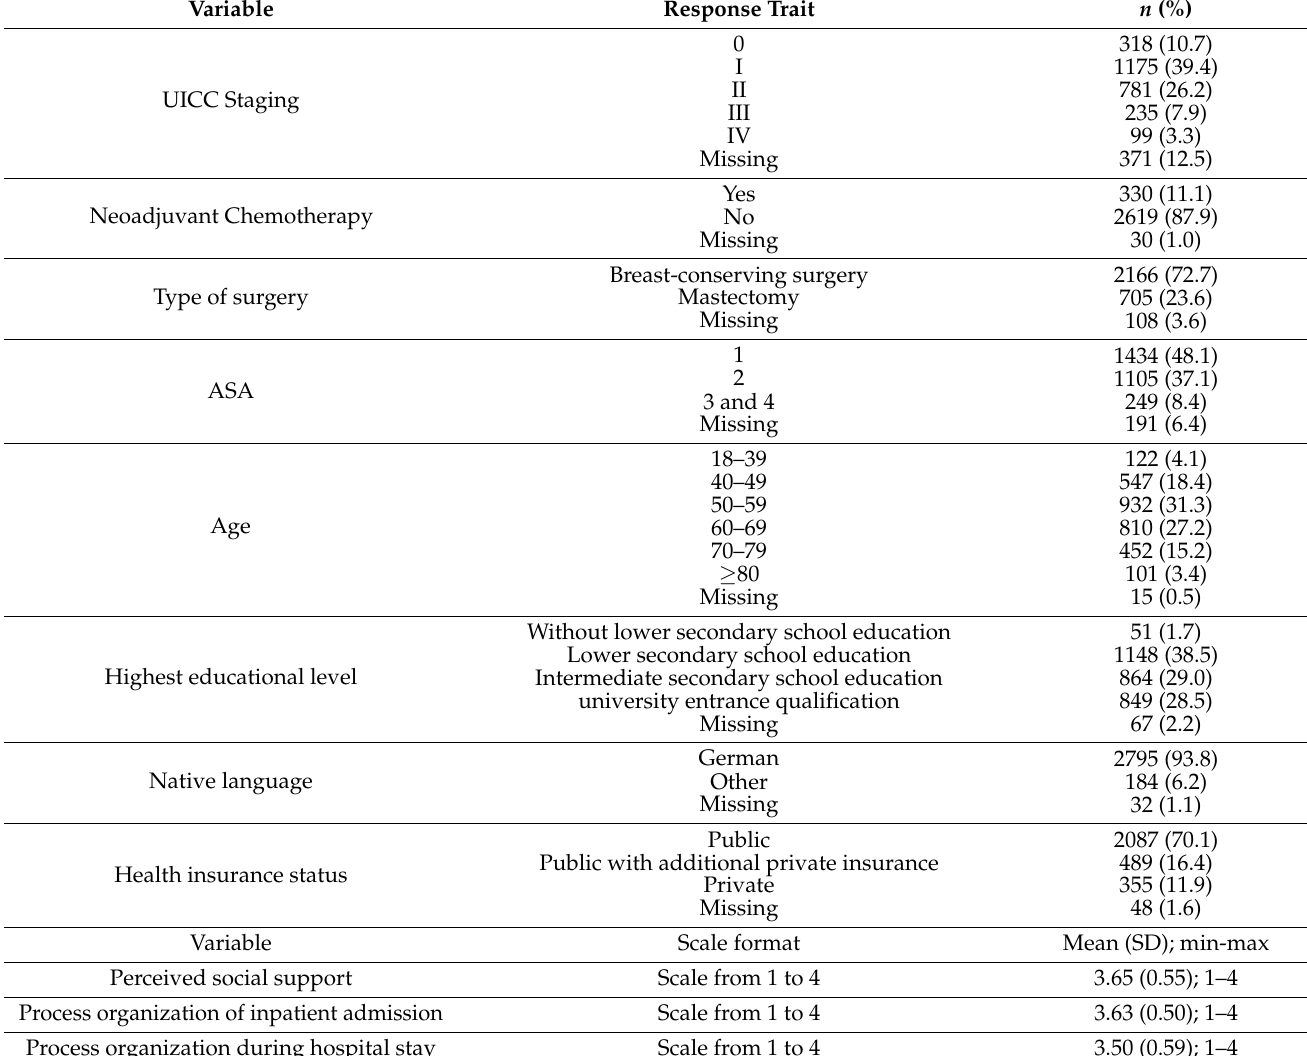
Table 2. Descriptive results of the patient-level variables ( n = 2979).